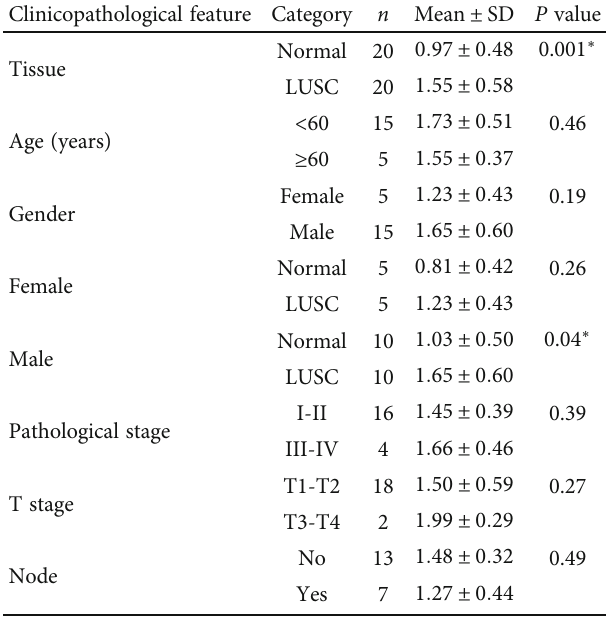
Figure 1: miRNA-33a-5p overexpression in LUSC based on RT-qPCR. (a) The expression level of miRNA-33a-5p in 20 LUSC and 20 normal lung tissues based on in-house RT-qPCR. (b) The ROC curve was generated to assess the diagnostic ability of miRNA-33a-5p in LUSC and normal lung tissues based on in-house RT-qPCR. AUC: area under the curve; CI: con fi dence interval; LUSC: lung squamous cell carcinoma; ROC: receiver operating characteristic; RT-qPCR: quantitative real-time Table 1: Associations between miRNA-33a-5p expression and clinicopathological features in LUSC based on RT-qPCR.